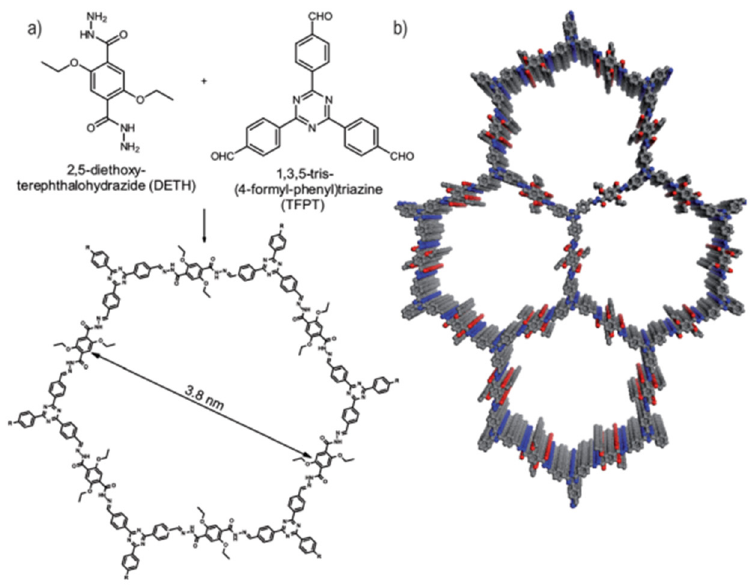
Figure 30. ( a ) Monomers and structure of a hydrazone-based COF (TFPT-COF); ( b ) The hexagonal lattice structure of TFPT-COF (grey: carbon, blue: nitrogen, red: oxygen). [Figure from ref. [134] under CC-BY 3.0 International License].